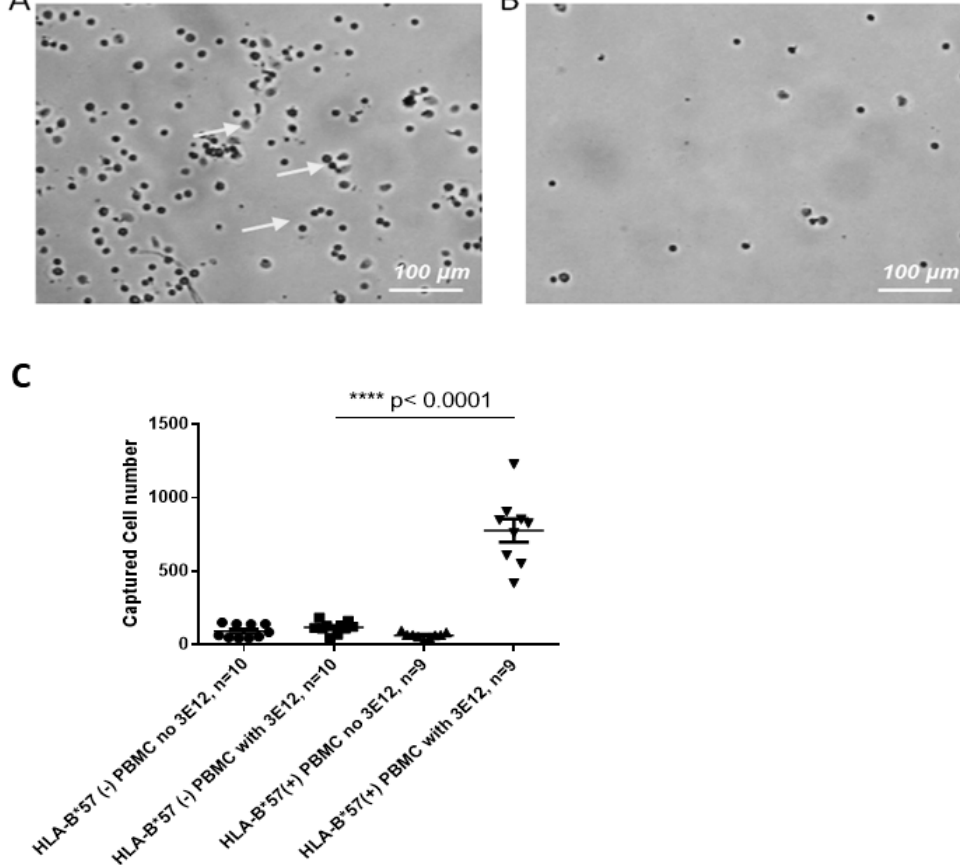
Figure 5. A 3E12 antibody capture HLA-B*57 expressing peripheral blood mononuclear cells (PBMCs) on glass surface. Glass surface showing more HLA-B*57 PBMCs captured on glass surface (white arrow) functionalized with a 3E12 antibody ( A ) compared to the surface without 3E12 antibody ( B ). ( C ) Significantly higher number of cells were captured when HLA-B*57 PBMCs were incubated with glass surfaces functionalized with a 3E12 antibody compared to other HLA group and controls at 0.5 mm 2 area (mean ± SEM. Bar = 100 μm).